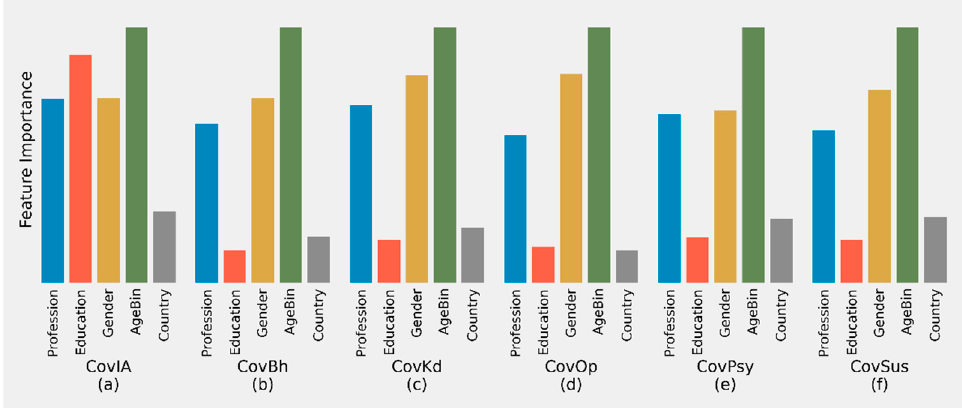
Figure 4. Plot of Feature Importance for determining different metrics using LightGBM.